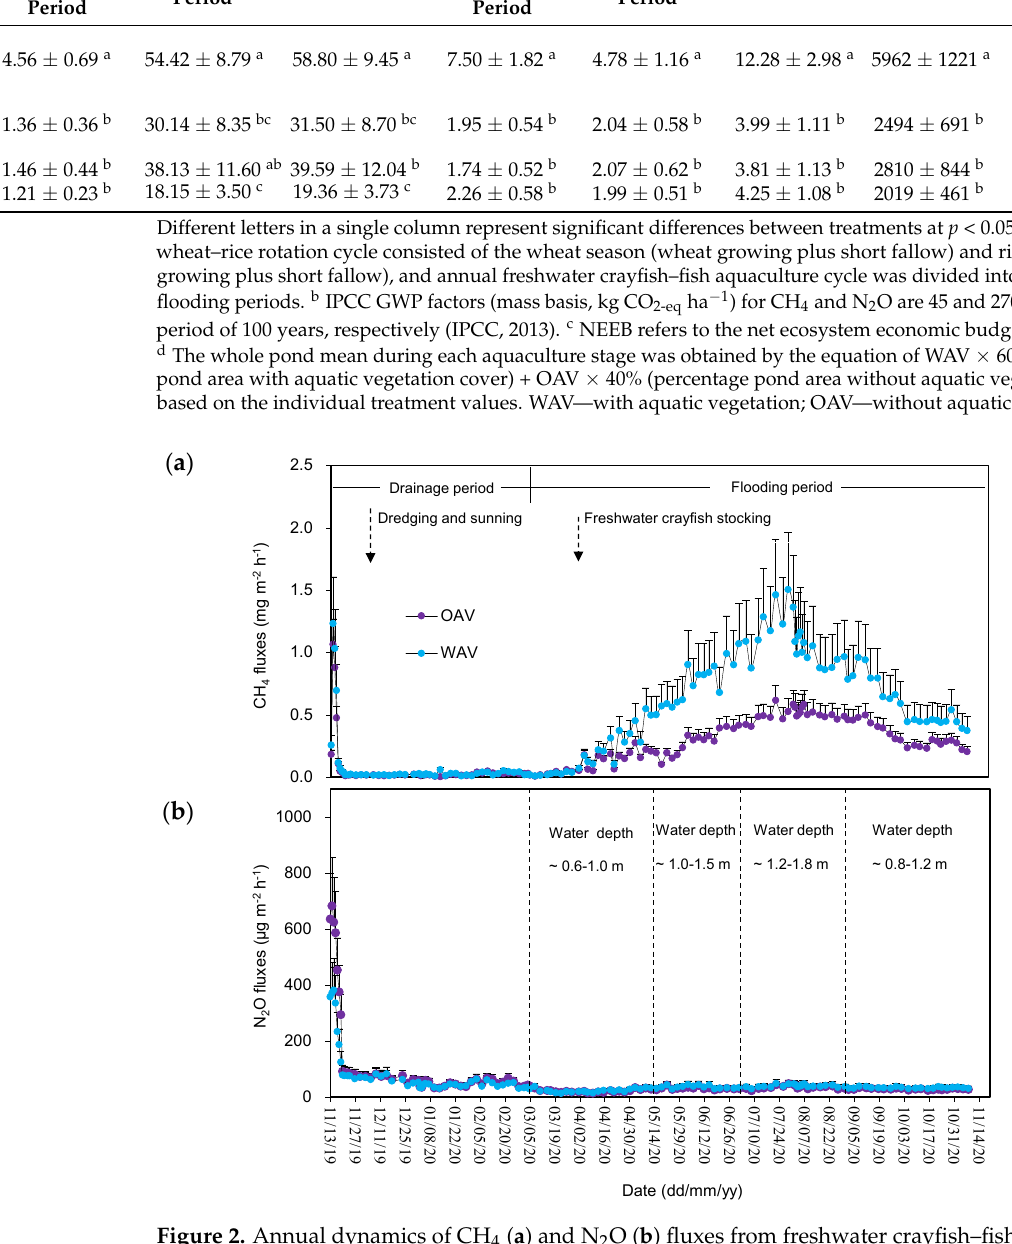
Figure 2. Annual dynamics of CH 4 ( a ) and N 2 O ( b ) fluxes from freshwater crayfish–fish aquaculture ponds. WAV and OAV—treatments with and without aquatic vegetation in crayfish–fish aquaculture ponds, respectively. Dotted arrows indicate the major management throughout the year.